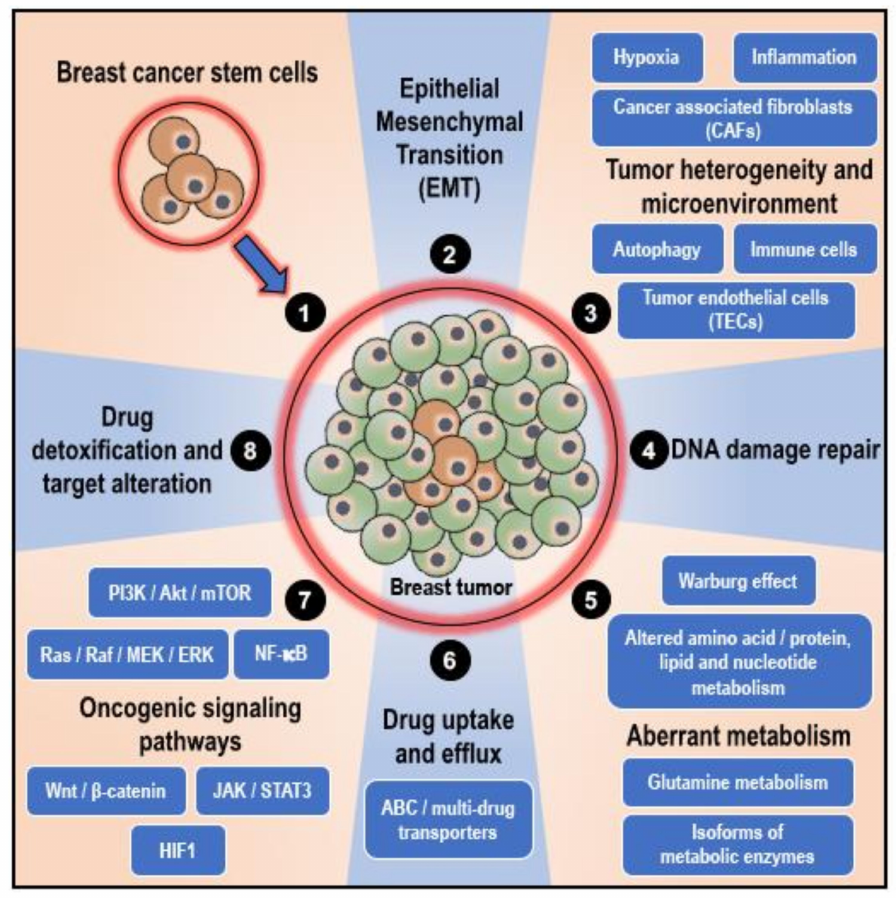
Figure 1. Mechanisms of chemoresistance in breast cancers: In breast cancers, the factors that influence therapeutic resistance mainly include (illustrated clockwise); ( 1 ) the presence and influence of breast cancer stem cells (BCSCs) that can initiate and re-populate tumors, ( 2 ) epithelial–mesenchymal transition (EMT), ( 3 ) tumor heterogeneity and microenvironment (characterized by hypoxia, inflammation, autophagy, and presence of cancer-associated fibroblasts, immune cells such as tumor-associatedmacrophages, andtumorendothelialcells), ( 4 )activeDNAdamagerepairmechanisms, ( 5 ) altered / adaptive / aberrant metabolism (characterized by the Warburg e ff ect, altered amino acid / protein / lipid and nucleotide metabolism, utilization of glutamine, and isoforms of metabolic enzymes that support cancer initiation, progression, and resistance to therapy), ( 6 ) variations in drug uptake and active drug e ffl ux systems (ATP binding cassette; ABC / multidrug transporters), ( 7 ) activation of oncogenic, pro-survival and anti-apoptotic signaling pathways (the phosphatidylinositol-3-kinase; PI3K / protein kinase B; Akt / mammalian target of rapamycin; mTOR, mitogen activated protein kinase; MAPK, nuclear factor-kappa B; NF- κ B, Wnt / β -catenin, janus kinase; JAK / signal transducer and activator of transcription 3; STAT3 and hypoxia inducible factor 1; HIF1 pathways), and ( 8 ) active drug detoxification and target alteration